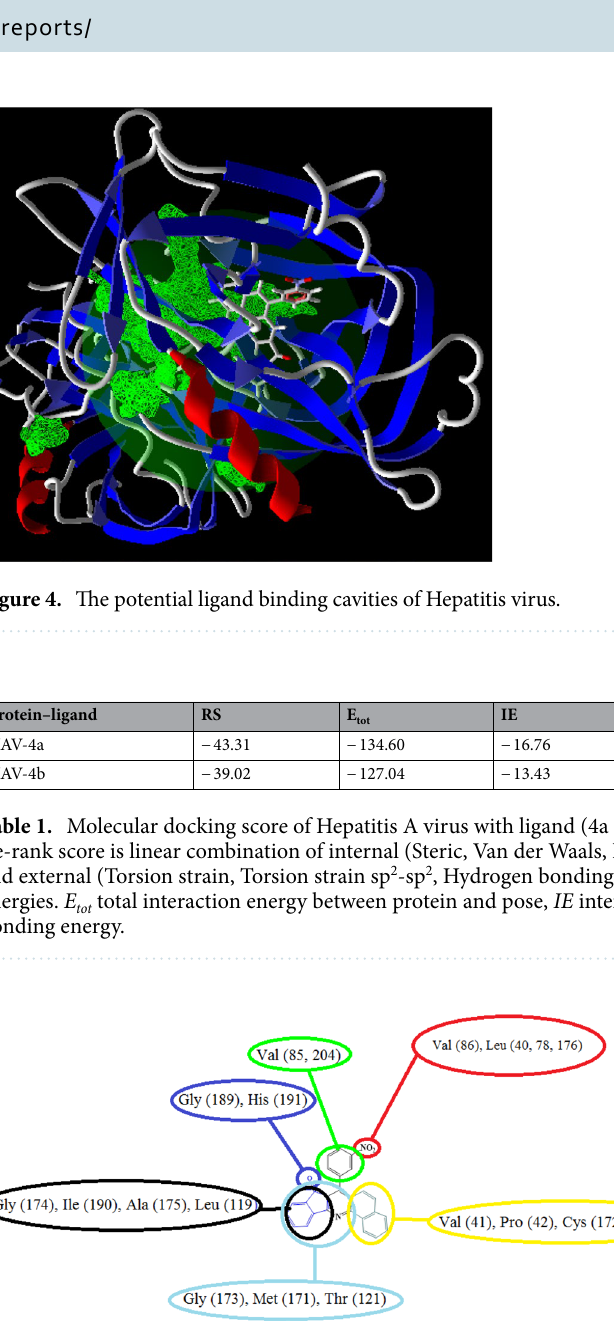
Figure 5. Molecular interaction between fused quinoline (4a, 4b) and active site of Hepatitis